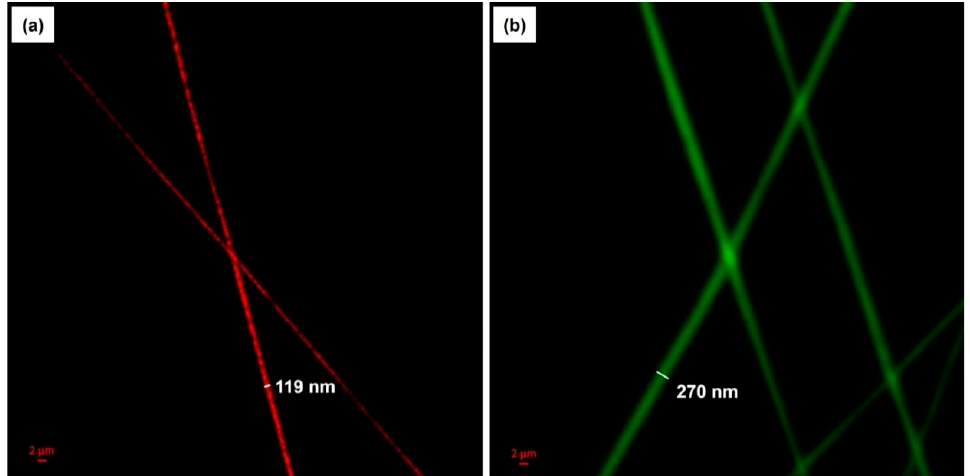
Figure 5. CLSM images of cinnamon oil/PVA nanofibers from emulsion C: ( a ) Cinnamon oil was stained by Nile red and viewed with excitation at 515 nm. ( b ) PVA was stained by FITC and viewed with excitation at 492 nm.